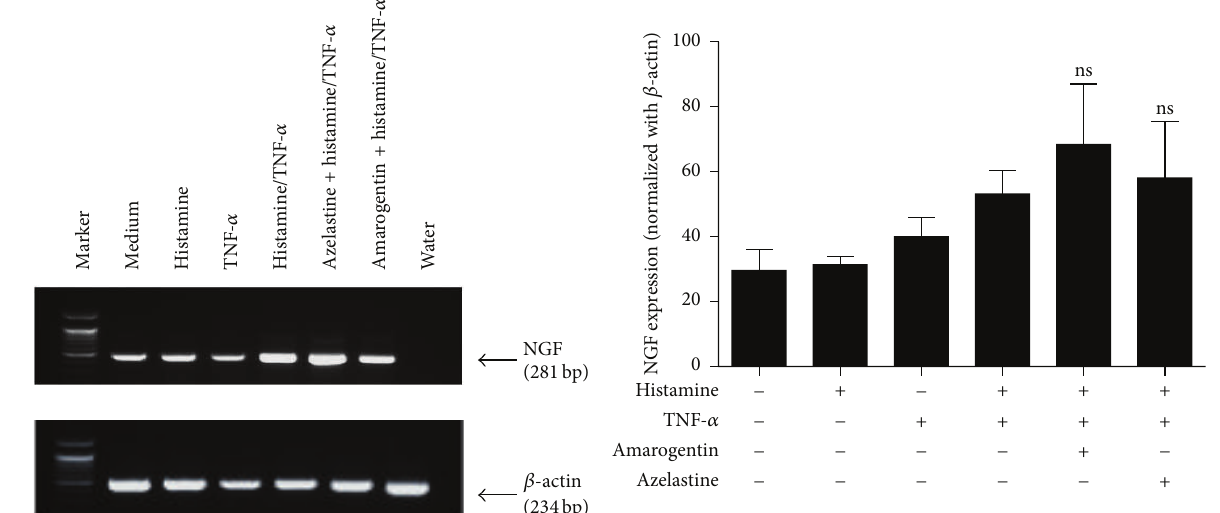
Figure 4: Amarogentin inhibits NGF secretion in stimulated HaCaT keratinocytes. HaCaT cells were costimulated with 10 𝜇 M histamine and 25 ng/mL TNF- 𝛼 and preincubated with amarogentin (100 𝜇 M) or the control azelastine (24 𝜇 M) for 30 minutes. After 4h NGF RNA expression was assessed. The data are shown with standard deviation (SEM) and were analyzed with the unpaired, two-tailed 𝑡 -test (ns: not statistically significant; 𝑛 = 3